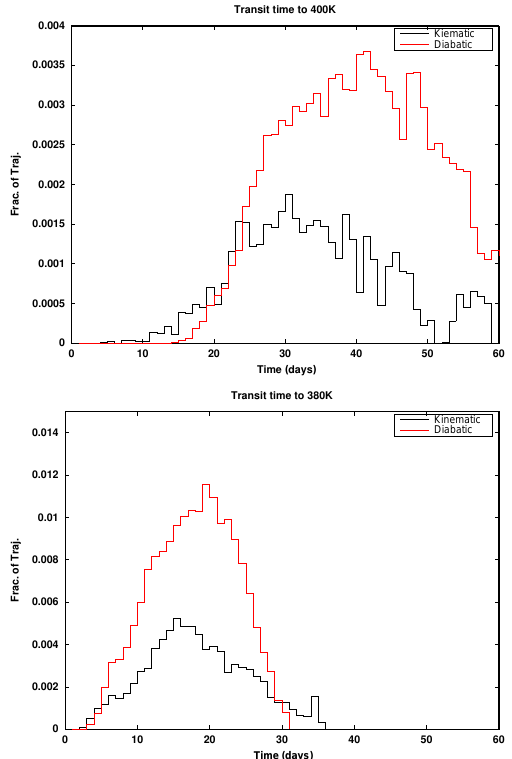
Figure 9. Transit time distribution from 360 to 380K (top panel) and to 400K (bottom panel) for diabatic (red) and kinematic (black) trajectories.